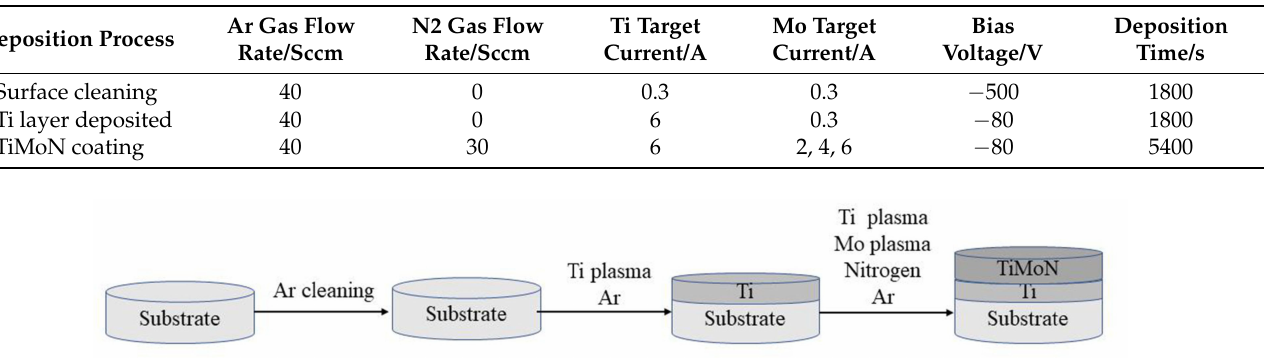
Table 2. TiMoN coating deposition process parameters.